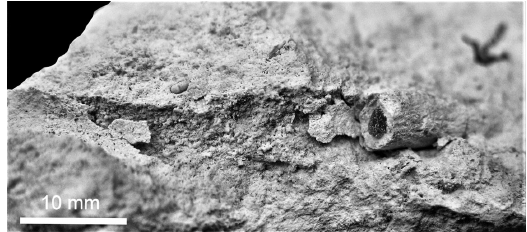
Fig. 7. Tube of porous debris with a core of chalcedony, a common trace fossil in type 1. RGM 1317644, Wilsum.